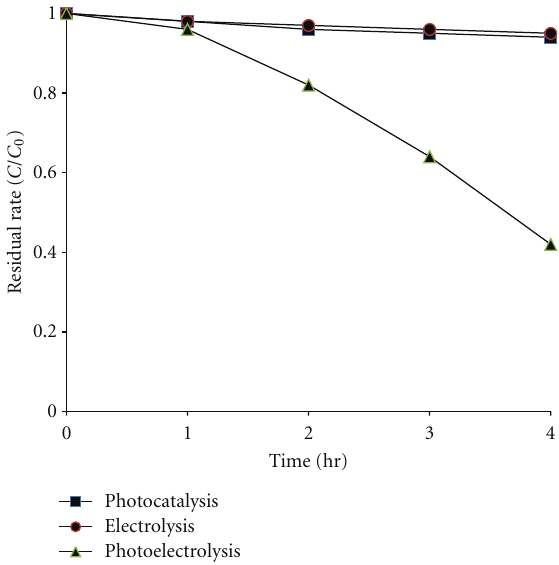
Figure 4: Residual rates of sodium oxalate under the di ff erent reac- tions at pH